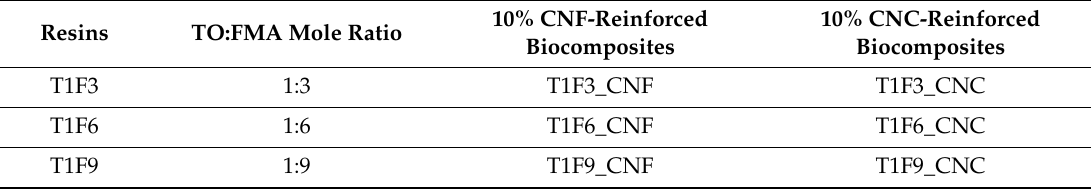
Table 1. Compositions and nomenclature of the resins and biocomposites used.